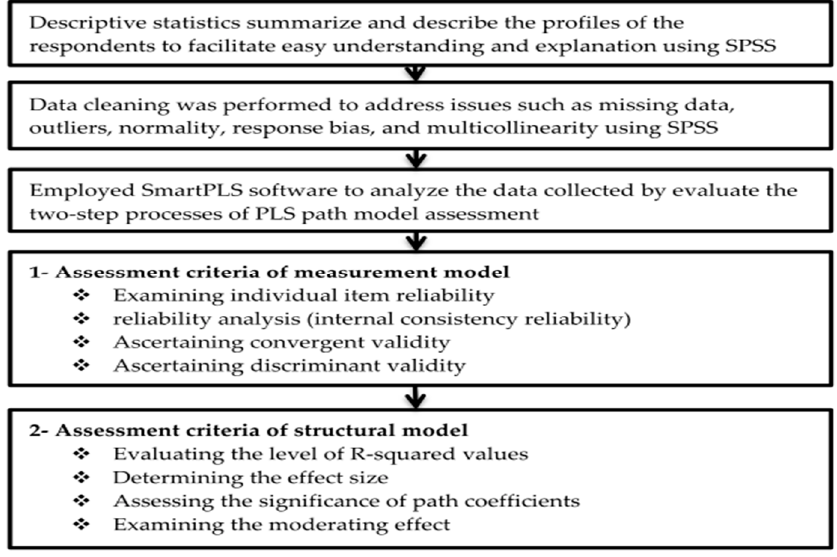
Table 2. Relevant indicators of the measurement model .